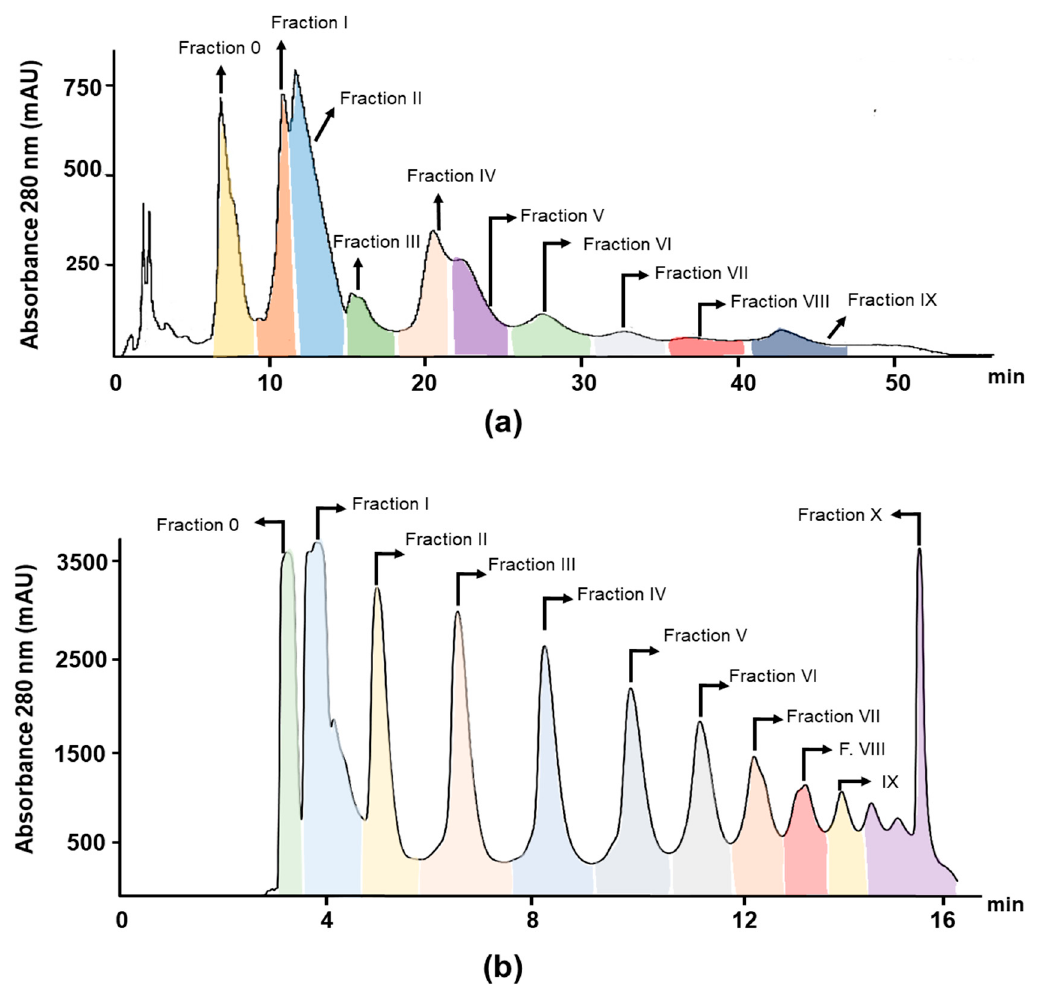
Figure 3. Preparative chromatogram obtained at optimum conditions using: ( a ) C18 stationary phase; and ( b ) diol stationary phase columns.